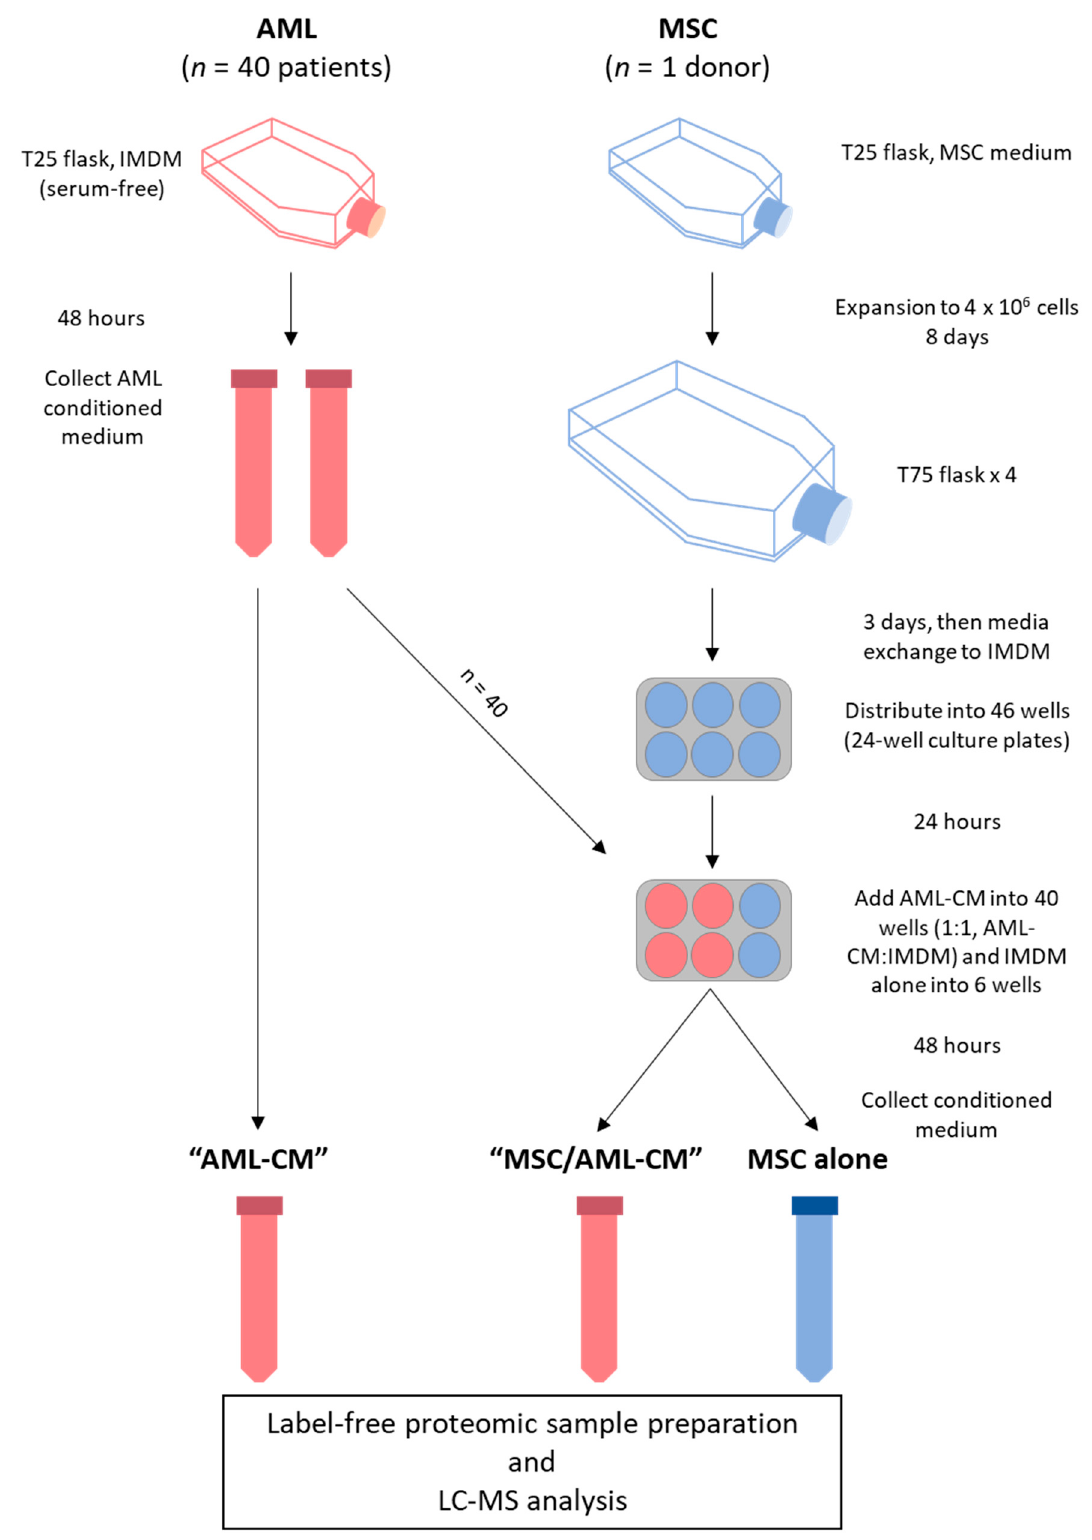
Figure 1. Experimental workflow. Conditioned media (CM) samples from 40 AML patient cell cultures were collected in two aliquots, of which one was analyzed alone (i.e., AML-CM) and one was added to MSC cultures derived from one donor in ratio 1:1 (i.e., MSC/AML-CM). Medium without AML-CM was added to six MSC cultures (i.e., MSCs alone). One aliquot of the MSC donor cells was also cultured under the same conditions as the AML cell cultures (not included in the figure). See Section 2.2 for details.